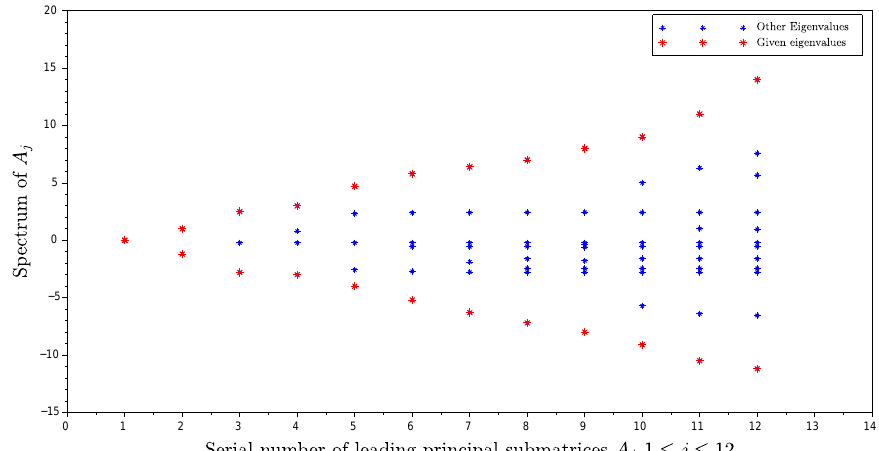
Figure 4: Distribution of eigenvalues of A j for